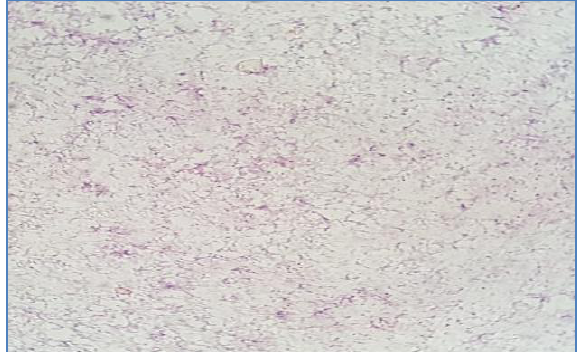
Figure, 2: Morphological properties of Campylobacter spp cultured on mCCDA examined by light microscope (X100) after 24 hours.